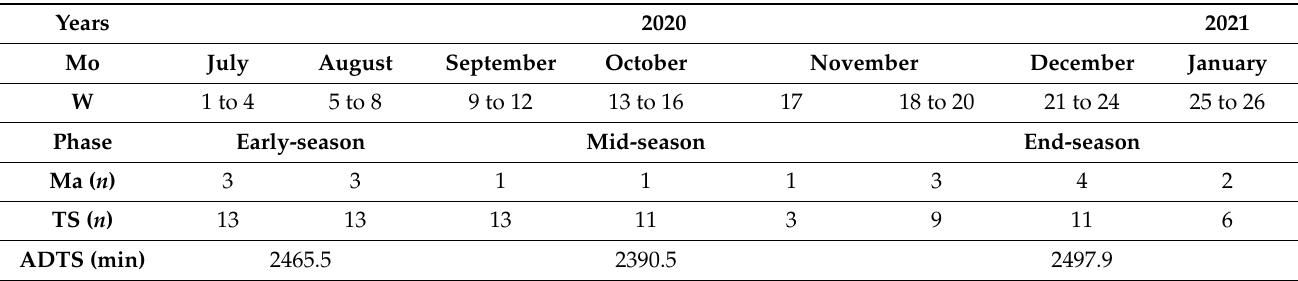
Table 2. Monitoring the periods of the full